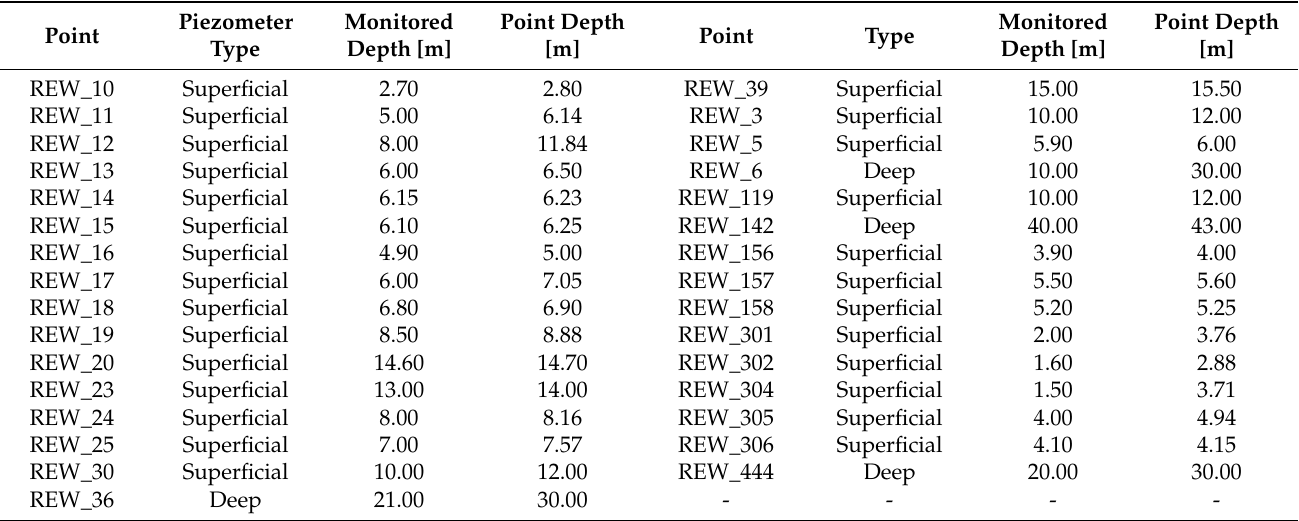
Table 1. List of the piezometers and wells used in the